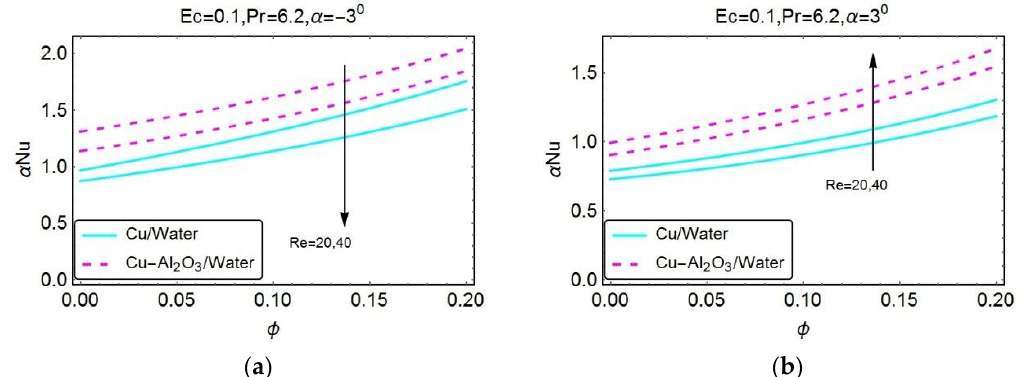
Figure 12. Stimulus of Re on αNu: ( a ) convergent case and ( b ) divergent channel. Table 3. Comparison for − F” (0) in narrowing case